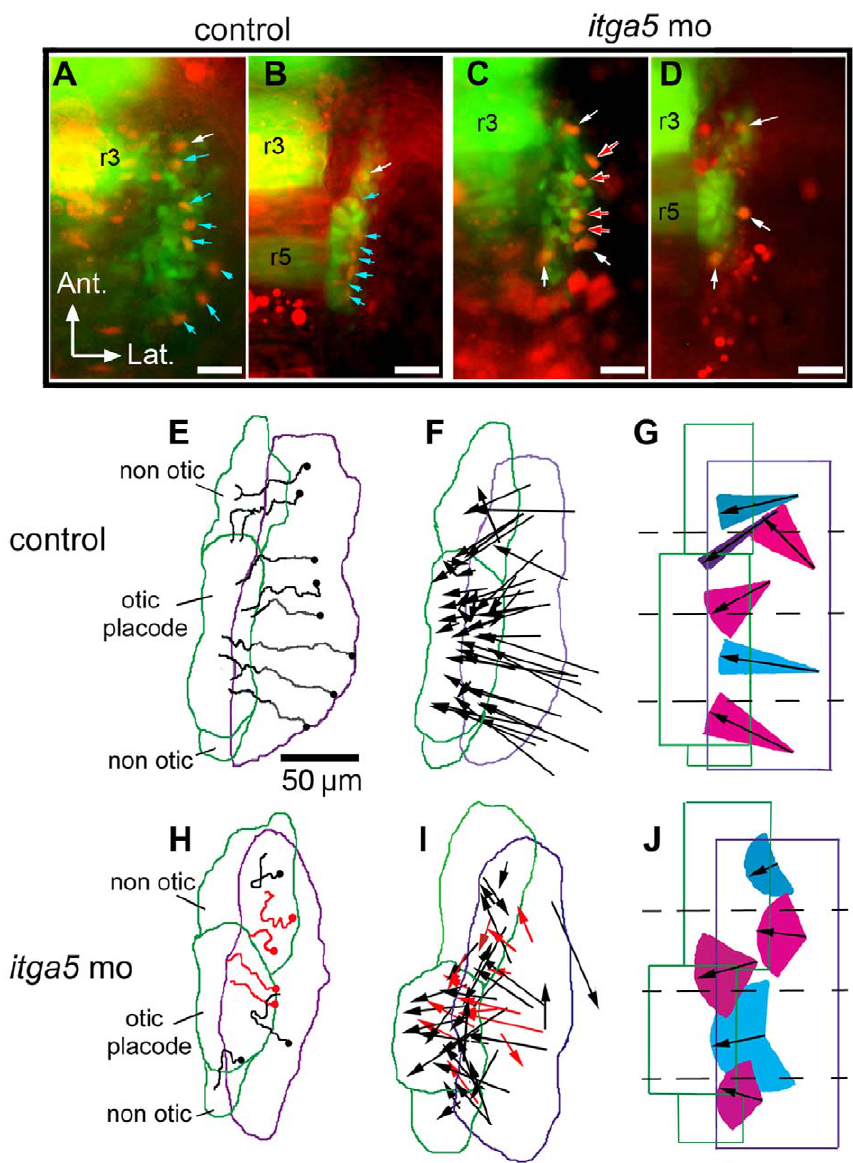
Figure 2. Otic/epibranchial precursors show aberrant migration in itga5 morphants. ( A–D ) Images from time-lapse movies showing transgenic expression of pax2a:GFP (green) and mosaic expression of cmv:RFP (red). The first frame (11.5 hpf) and final frame (14.5 hpf) of a control movie (A, B) and itga5 morphant movie (C, D) are shown. Arrows indicate cells that expressed both GFP and RFP. Blue arrows indicate cells that contributed to the otic domain, and white arrows indicate cells that contributed to non-otic domains. Red arrows indicate cells that lysed during the recording period (C, D). Positions of rhombomeres 3 and 5 (r3, r5) are indicated. ( E, H ) Maps showing the trajectories of all marked cells in the embryos recorded in A–D. Trajectories in red denote cells that lysed during recording (H). The origins of cell trajectories are marked with dots. The initial and final positions of the pax2a:GFP domain are indicated by purple and green boundaries, respectively. Final positions of the otic placode and non-otic domains are indicated. ( F, I ) Vector maps showing net displacement of all cells tracked in 5 control movies (F) and 4 itga5 morphant movies (I). Red arrows indicate cells that died during recording (I). ( G, J ) Summaries of average migration patterns of cells in different quadrants of the pax2a:GFP domain in control embryos (G) and itga5 morphants (J). Arrow length indicates the mean of the net displacement of cells in the indicated region, and colored cones represent the range of angle of net displacement. Quadrants 1 and 2 contained cells contributing to both otic and non-otic domains, which were grouped separately. All images depict the right half of the embryo with lateral to the right and anterior to the top. Scale bar, 50 m m.